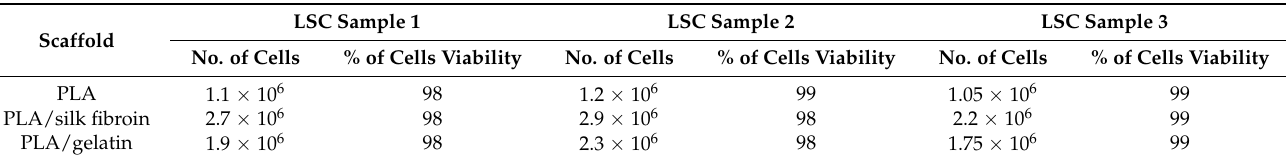
Table 1. Viability and number of LSCs stripped from PLA and modified PLA scaffolds. Scaffold